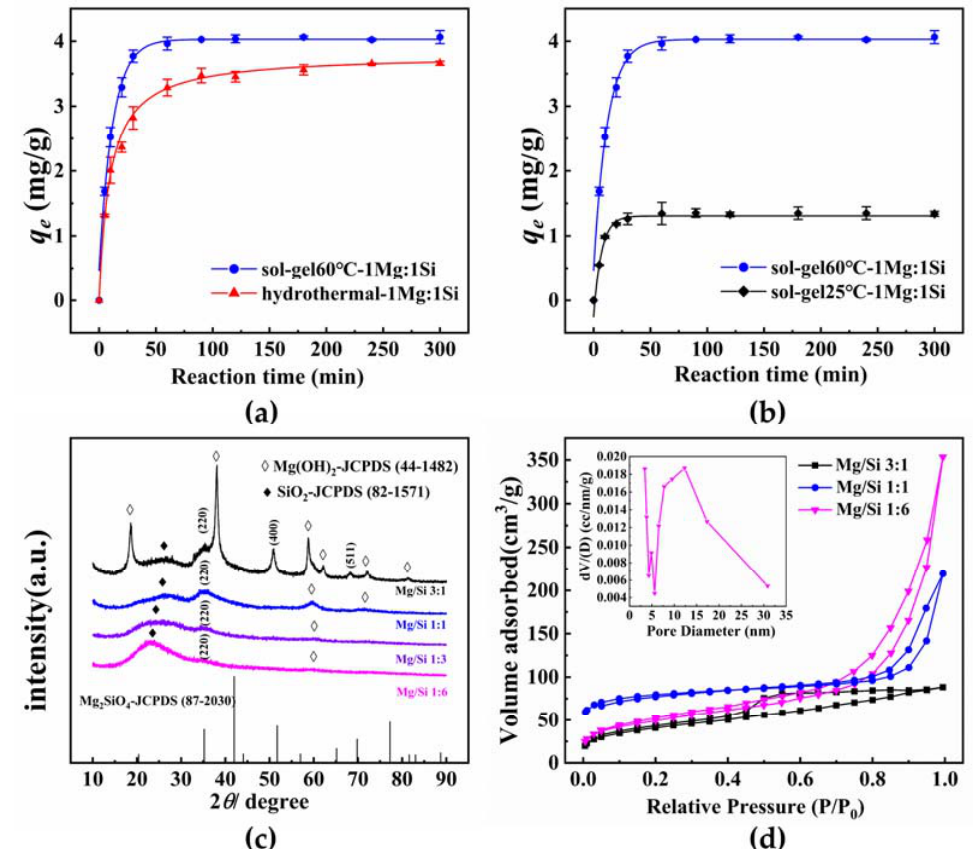
Figure 1. Influence of synthesis methods ( a ) and reaction temperature of sol − gel method ( b ) for synthesis magnesium silicate on adsorption capacity for 4 − NP. XRD pattern ( c ) and N 2 adsorp ‐ tion − desorption ( d ) with different Mg/Si